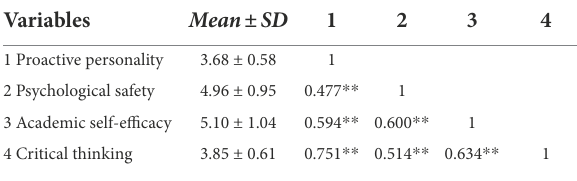
TABLE 1 Demographic characteristics of study participants ( N = 5,920). Characteristics